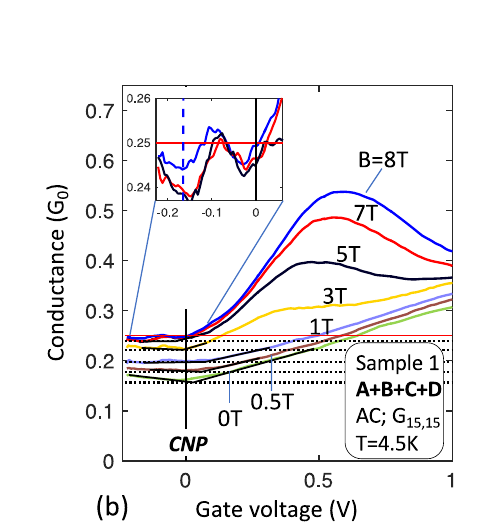
B isconsistentwith4conductors(eachofconductance ≈ 1 G 0 )inseries,asexpected for a 1 G 0 ballistic conductor with 3 isotropic scattering centers (3 junctions). In a magnetic fi eld, the conductance increases to ¼ G 0 (see inset for B=5, 7, 8T) indi- cating essentially perfect quantization, which implies that λ AC diverges and R J